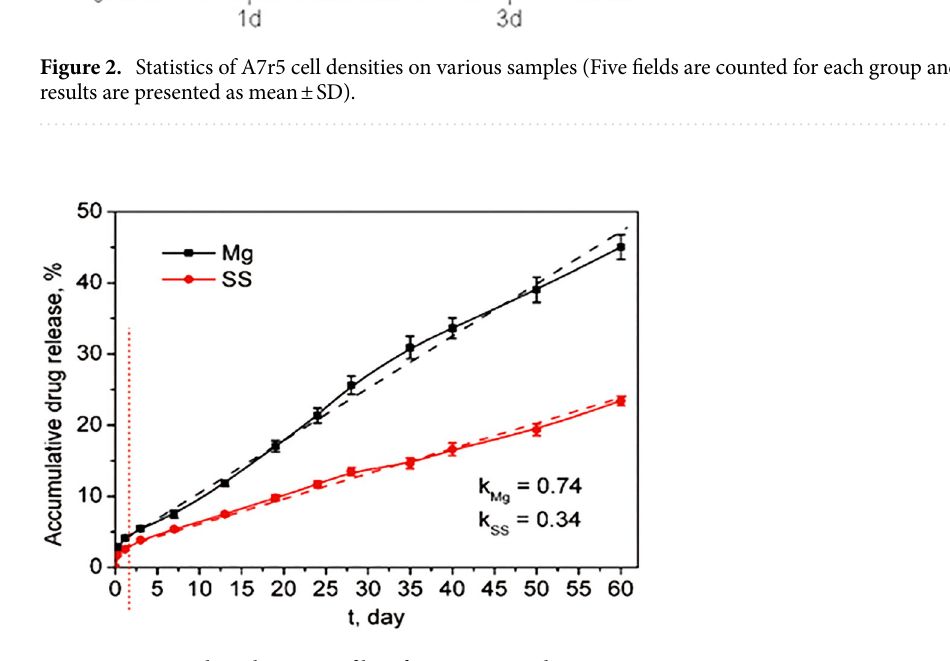
Figure 3. Drug release kinetic profiles of JDBM BRS and SS BRS.